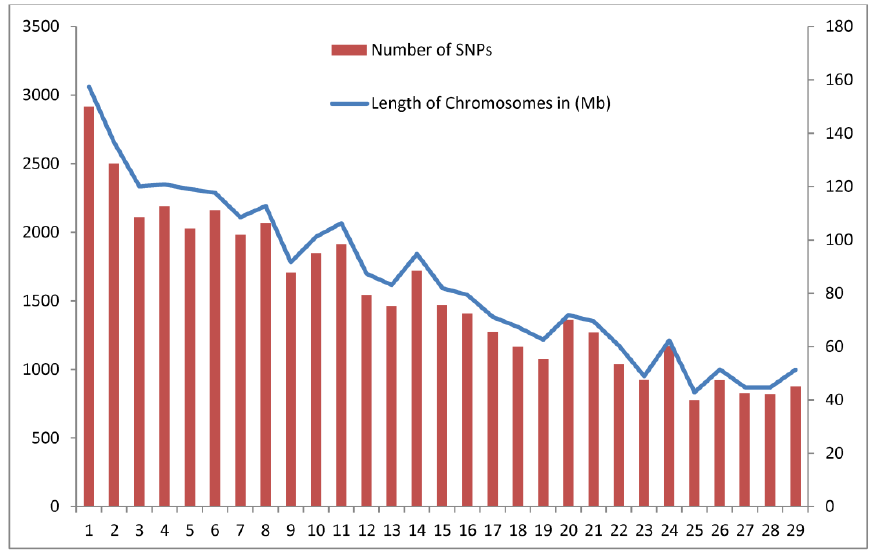
Figure 2. Summary of SNPs and chromosome lengths included in the analysis. Red bars indicate the number of SNPs and the blue line indicates chromosome